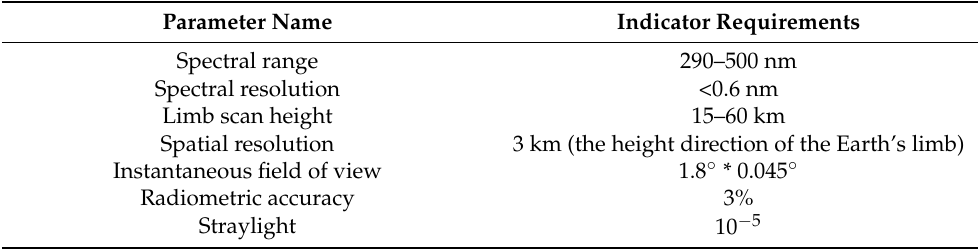
Figure 3. Schematic diagram of limb scanning detection. Table 2. Main parameters of Ultraviolet Hyperspectral